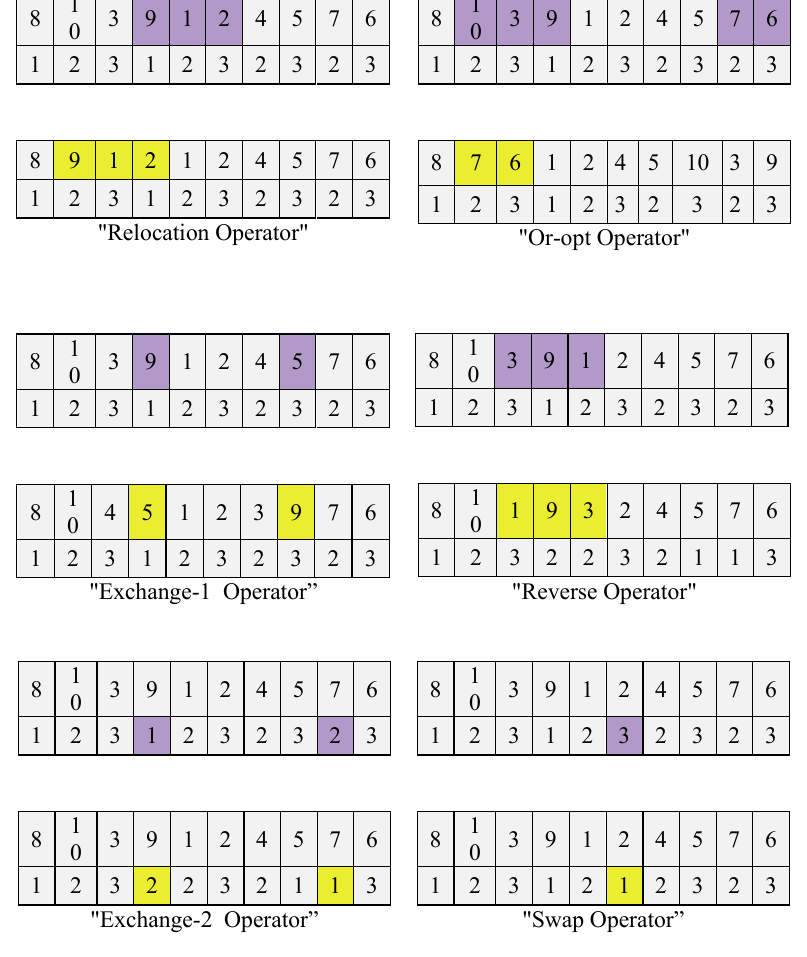
Fig. 7. Local search operators applied for the generation of new solution in the SA